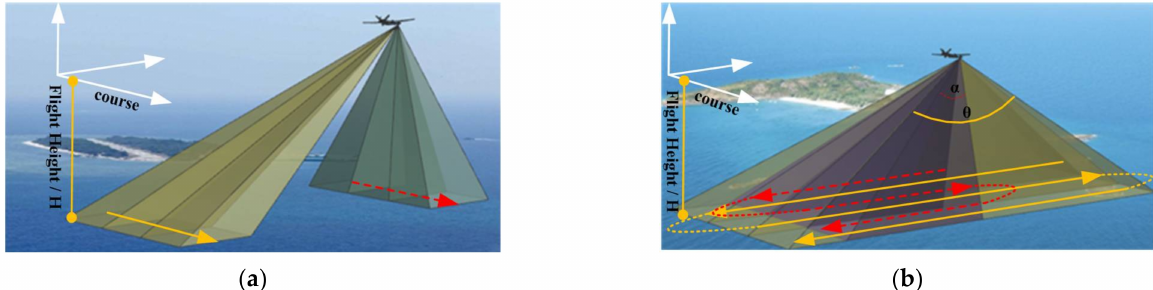
Figure 1. Schematic diagram of the main working modes of the oblique airborne mapping camera: ( a ) vertical downward view/oblique view; ( b ) ± 60 ◦ full-amplitude/interval scanning.